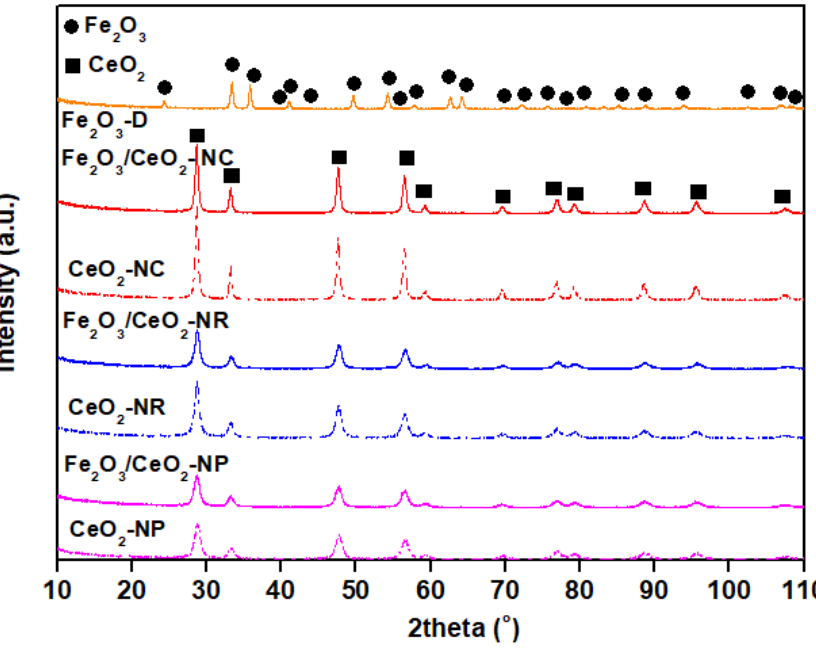
Figure 2. XRD patterns of bare CeO 2 , Fe 2 O 3 -D, and Fe 2 O 3 / CeO 2 samples.